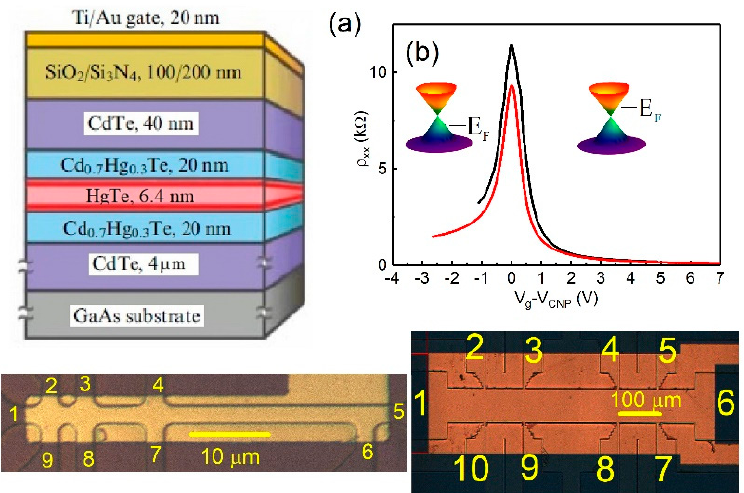
Figure 1. (Color online) ( a ) Schematic of the transistor. ( b ) Resistivity ρ xx as a function of gate voltage measured for different devices. The red trace—macroscopic and black line—mesoscopic devices. The bottom of the figure presents a top view of the samples.